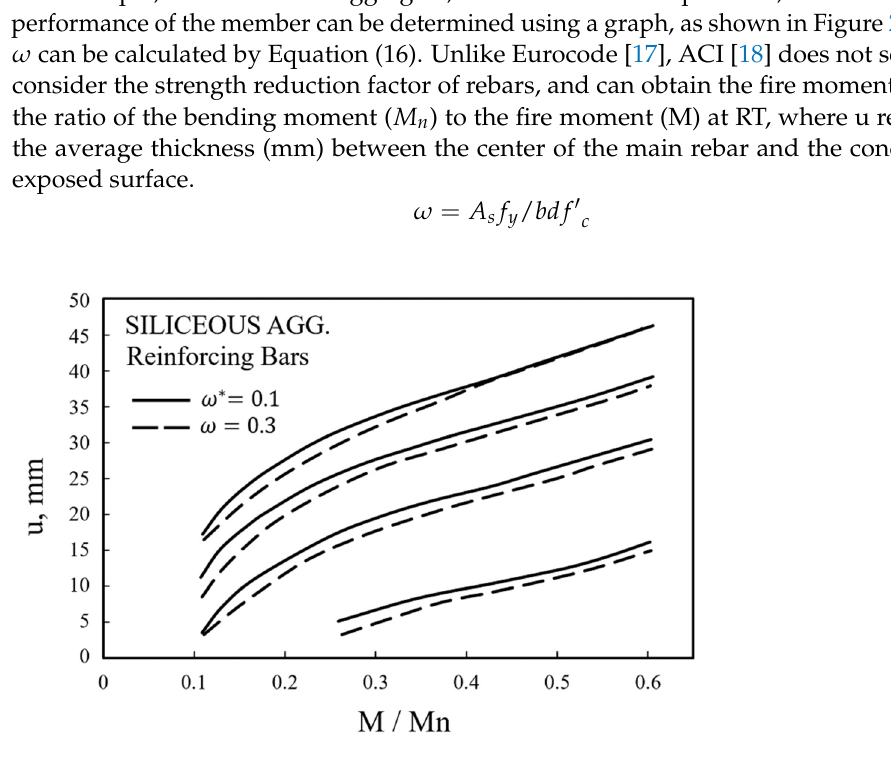
Figure 21. Simply supported beam and slab design (siliceous aggregates,